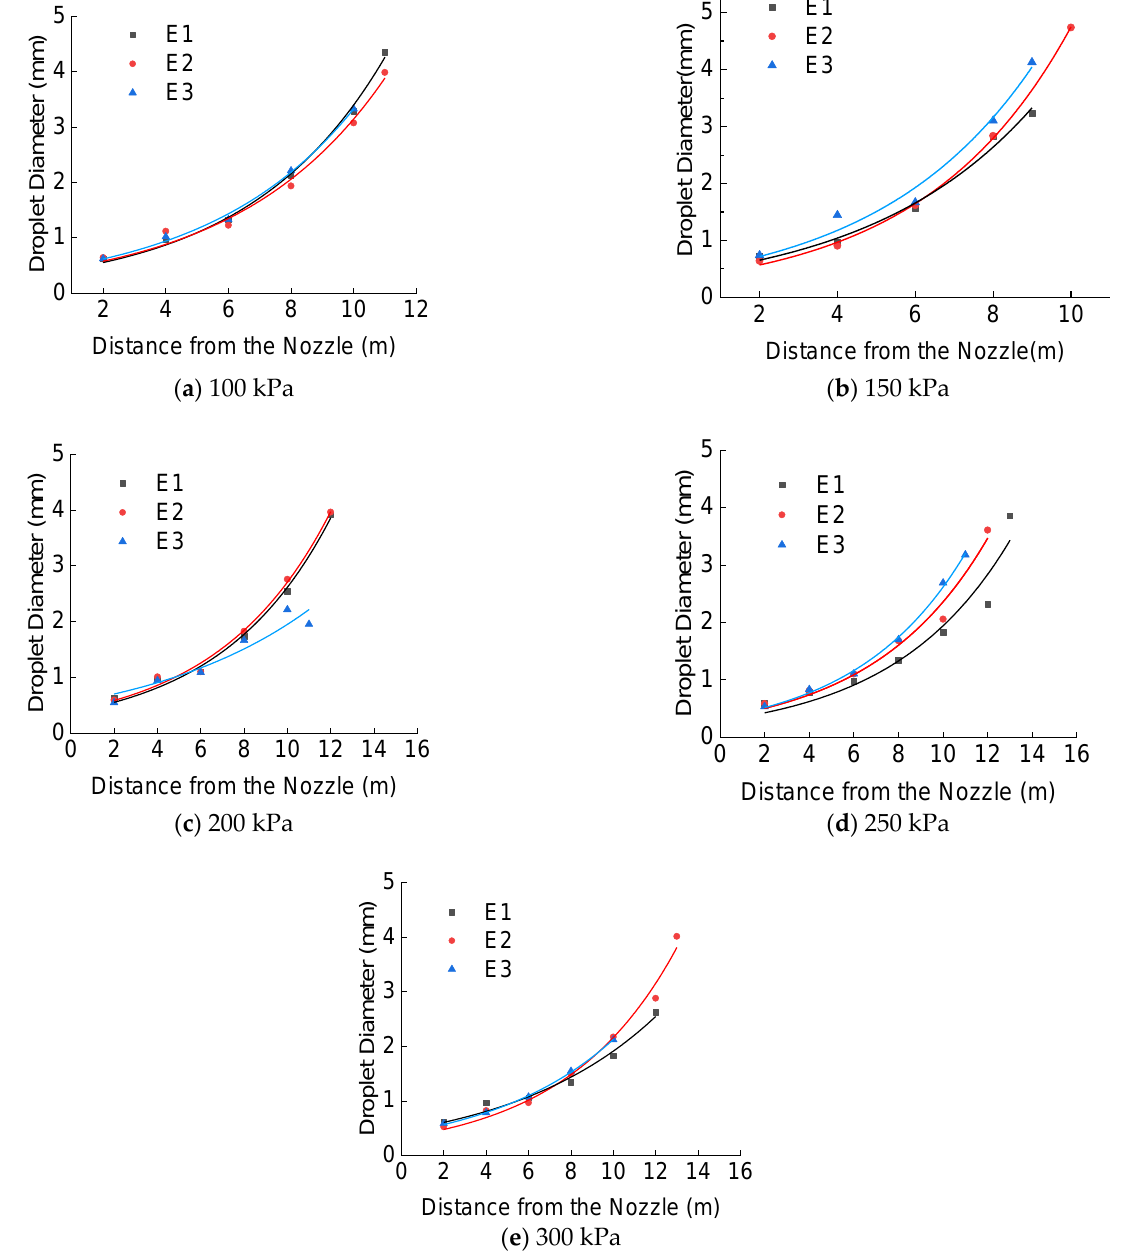
Figure 13. Relationship between mean droplet diameter and distance from the nozzle for different aspect ratios at different working pressure levels. (E1, E2, and E3 refer to the elliptic nozzles with aspect ratios of 1.43, 2, and 2.58, respectively).